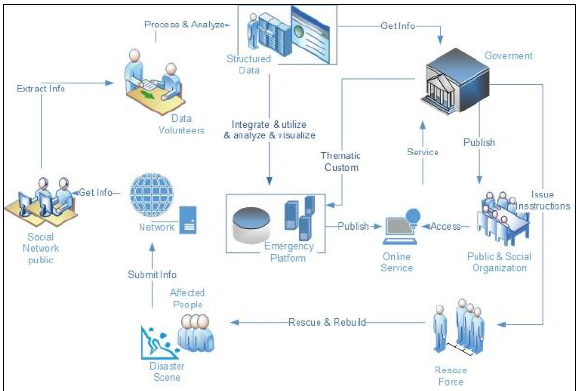
Figure 1. Multi-source emergency geographic